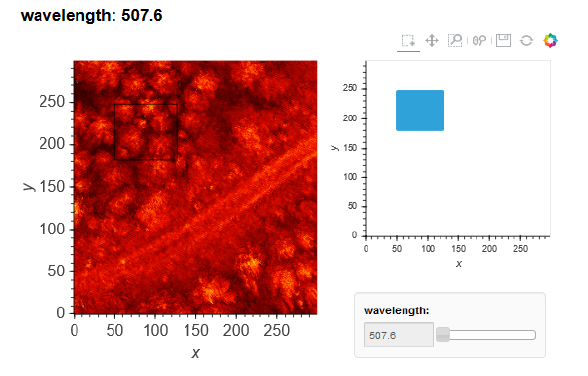
Figure 15. Screenshot of the box chooser.